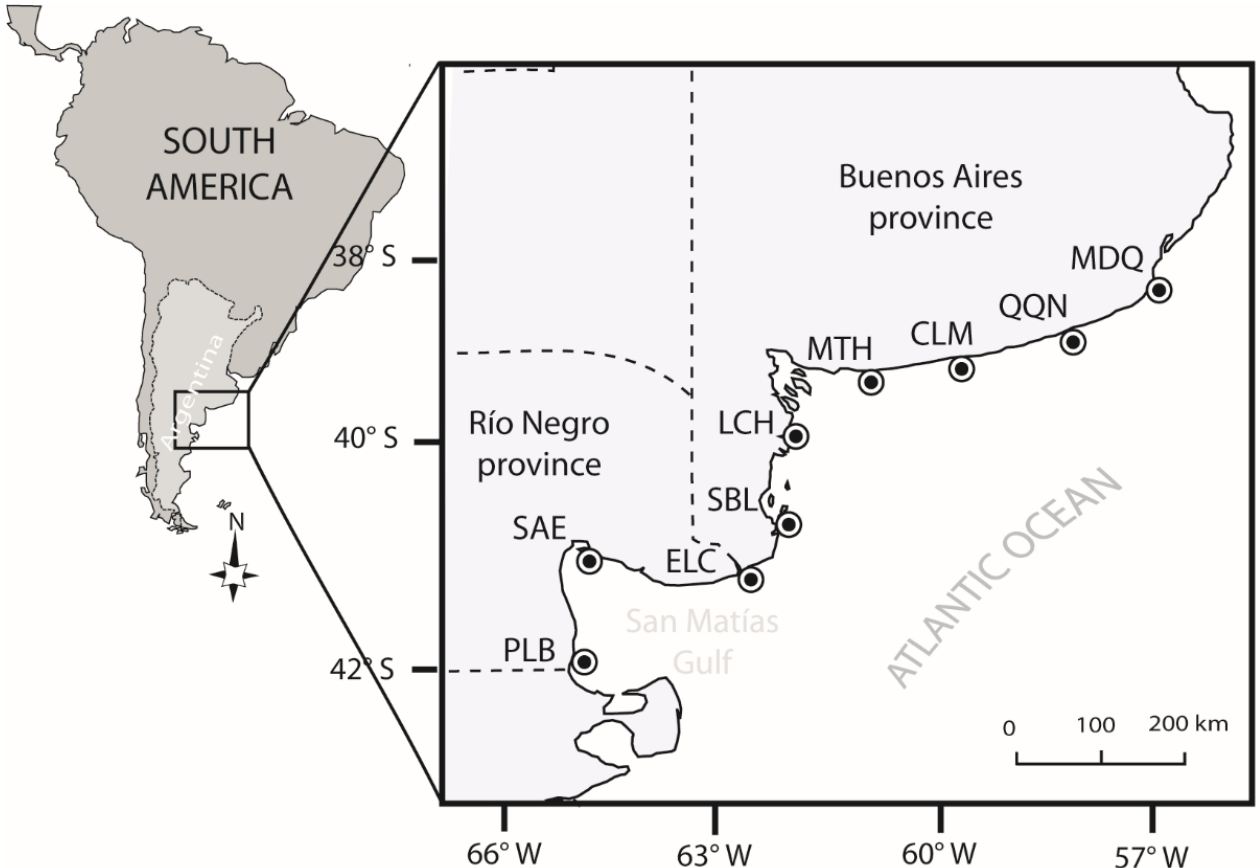
Figure 1. Sampling sites. MDQ: Mar del Plata; QQN: Quequén; CLM: Claromecó; MTH: Monte Hermoso; LCH: La Chiquita; SBL: San Blas; ELC: El Cóndor; SAE: San Antonio Este; PLB: Puerto Lobos.